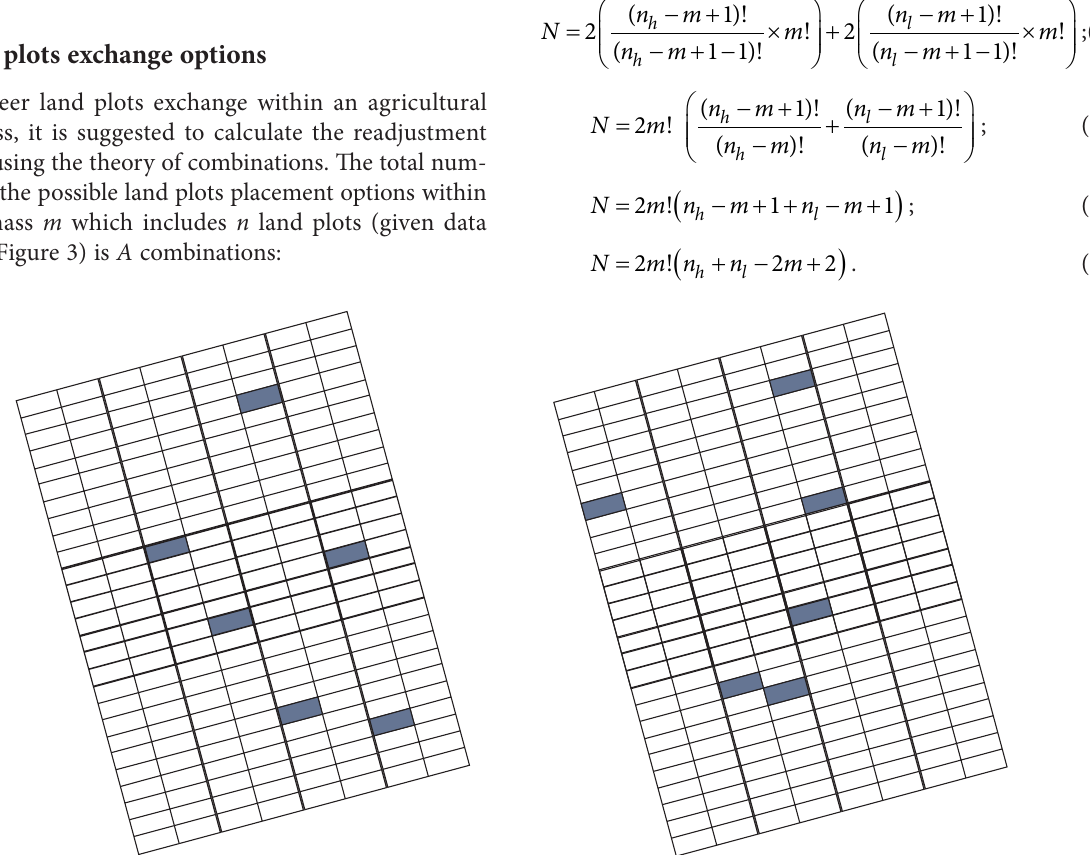
Figure 3. Random land plots placement options within a land